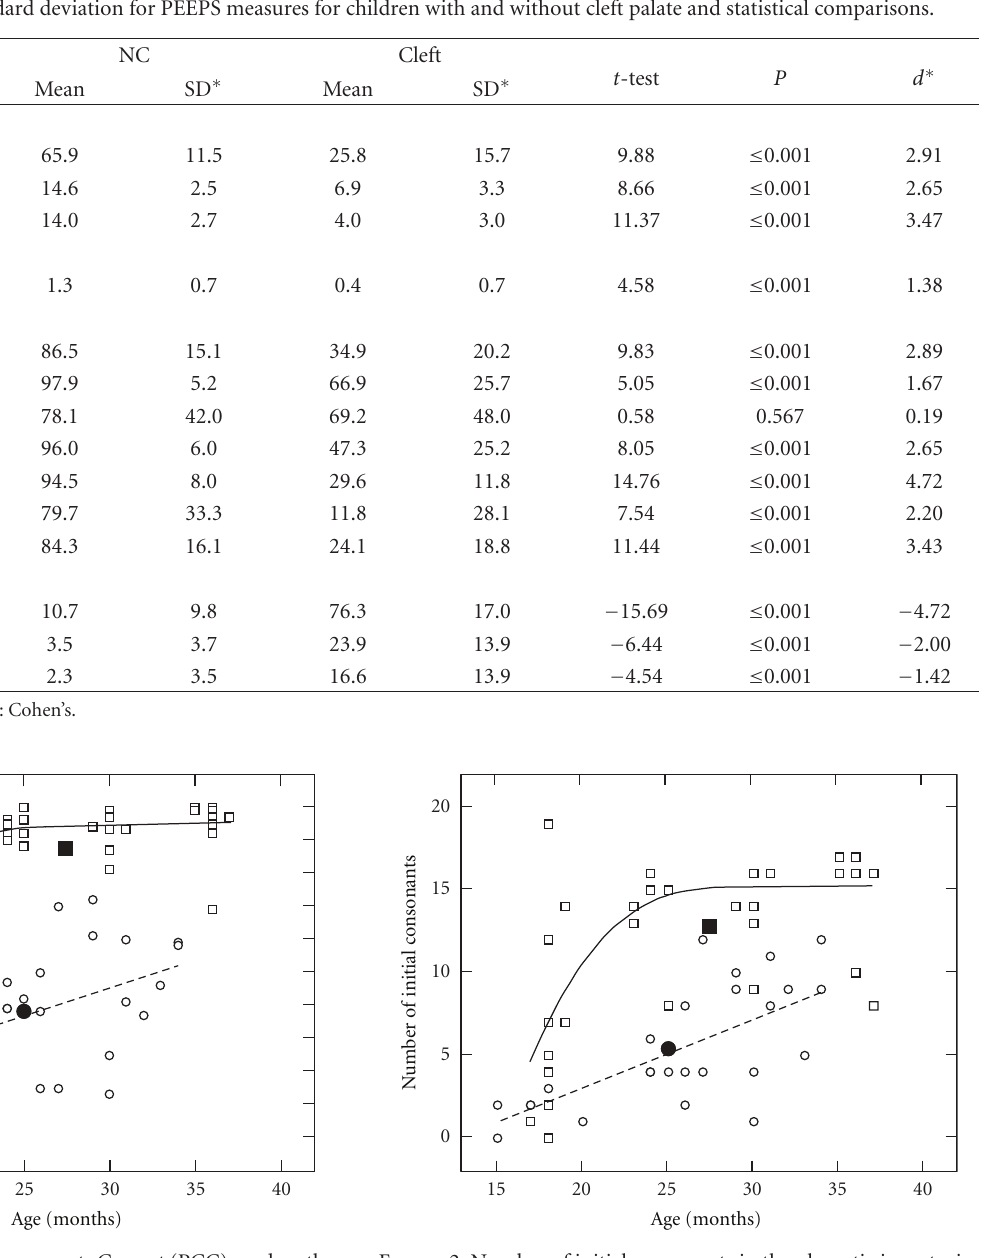
Figure 2: Number of initial consonants in the phonetic inventories of the children with and without CLP across age determined from the PEEPS. The number of correct initial consonants used on the PEEPS for children with CLP (circles) and NC children (squares) across the ages of 18 to 36 months. The linear (CLP: dotted line) and curvilinear (NC: solid line) polynomials and means (filled symbols) are displayed for the